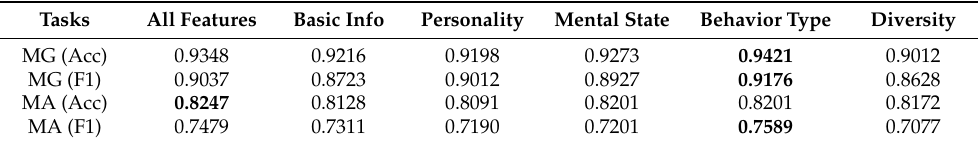
Table 6. Performance (Accuracy and F 1 score ) on two tasks using different features to cluster on Dataset1. MG indicates model generalization and MA represents model adaptation Tasks All Features Basic Info